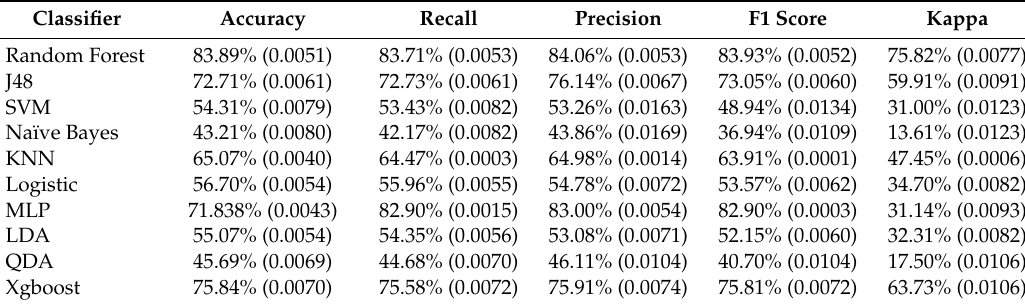
Table 13. Classifier performance on lifting di ff erent